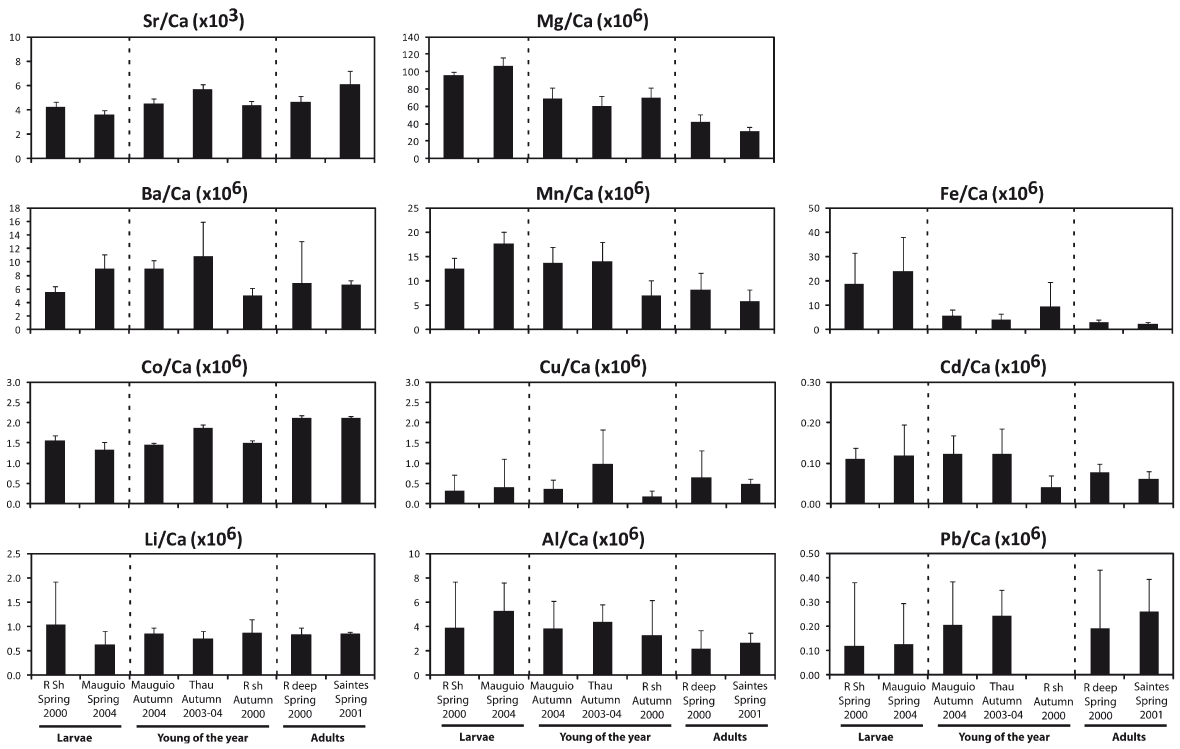
Table 2. – Results of one-way MANOVAs achieved with elemental composition (in ratios to calcium) and isotopic ratios of otoliths for each life stage studied. NS, non-significant; Thau aut. grp, Thau autumn 2003 and 2004 grouped. One-way MANOVAs comparisons F p LSD Post-hoc elemental differences Larval signatures Rhône sp. vs Mauguio sp. Juvenile signatures Thau aut. 2003 vs 2004